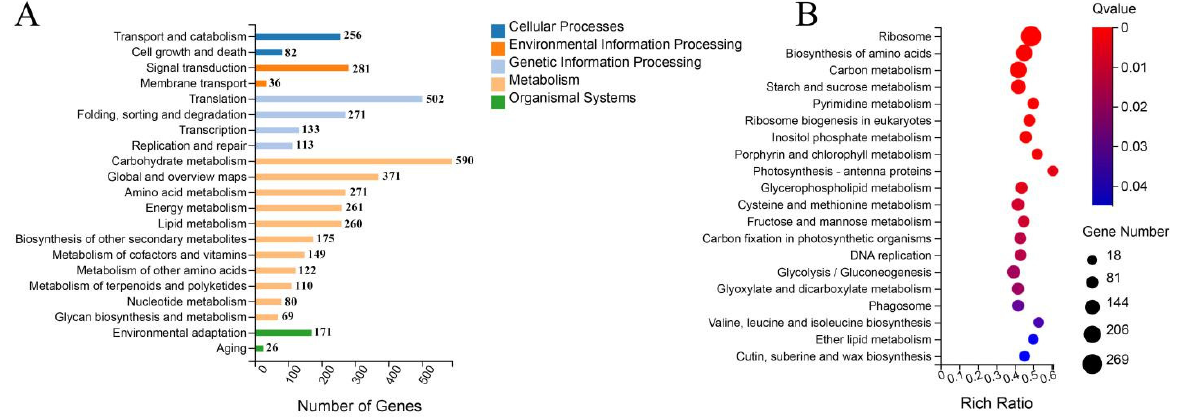
Figure 5. KEGG pathway enrichment analysis of the set of DEGs in different periods between ‘116’ and ‘117’. ( A ) Secondary classification of the KEGG pathways of DEGs. ( B ) Scatter plot of DEG enrichment in the top 20 KEGG pathways.